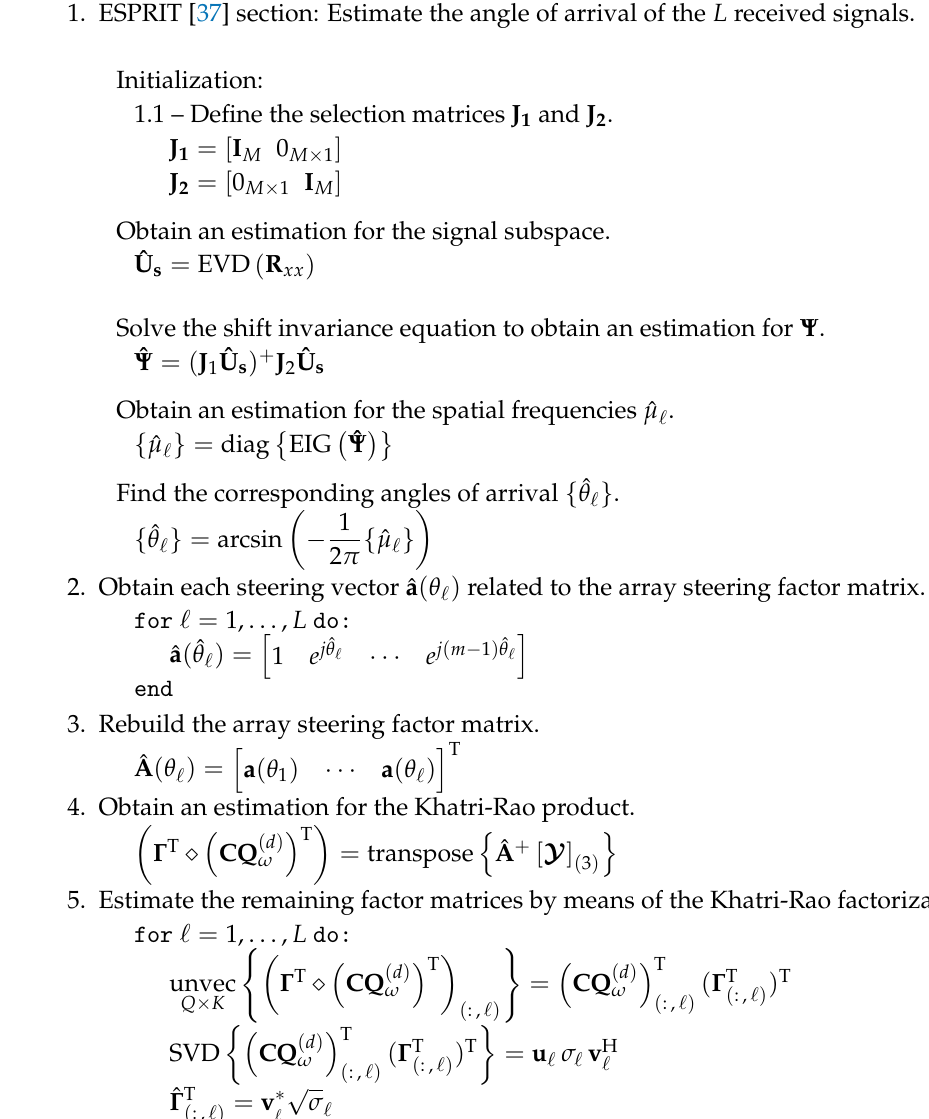
Algorithm A1: DoA/KRF Time-delay estimation